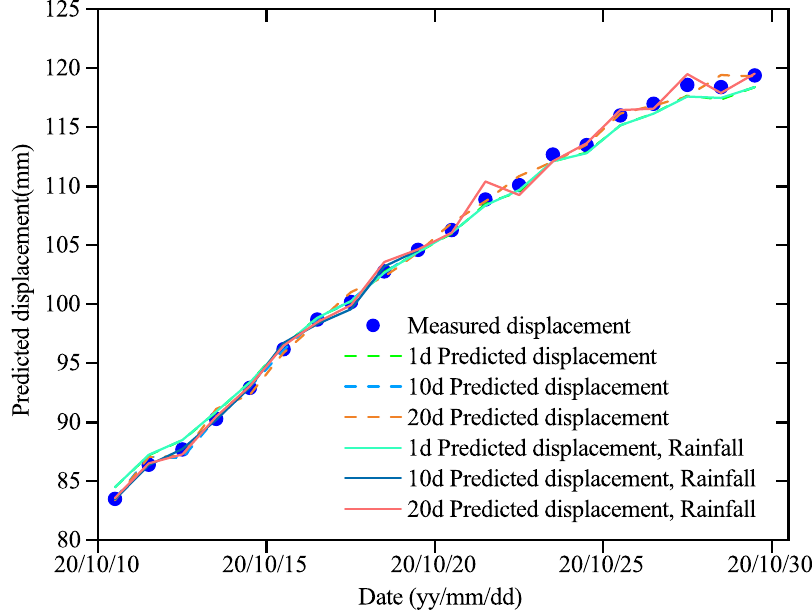
Figure 6. Prediction and comparison of GA-Elman model on test